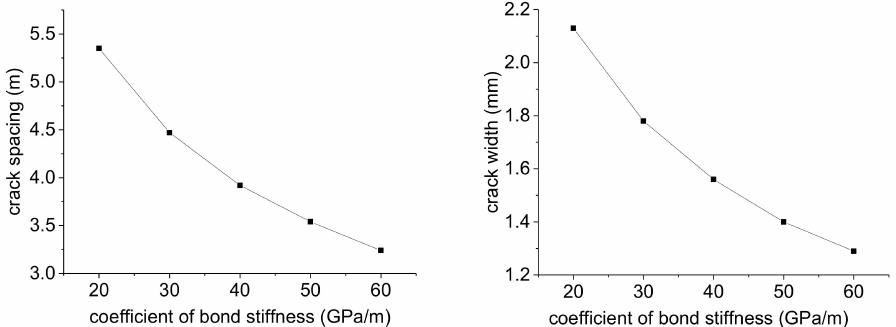
Figure 11. Impact of the coe ffi cient of the bond sti ff ness of BFRP on the crack spacing ( left ) and crack width ( right ) of CRCP with BFRP